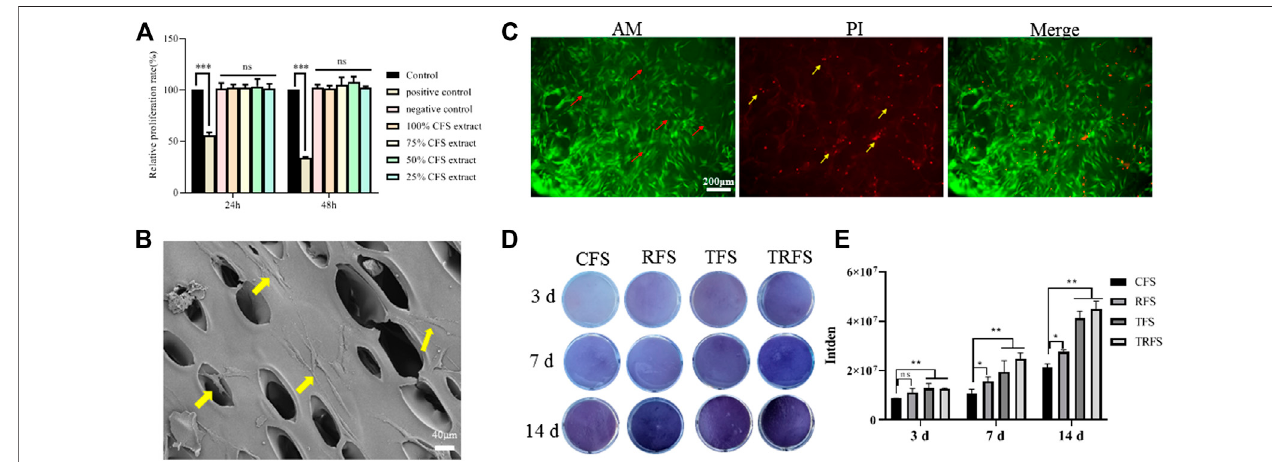
FIGURE 2 | Cell growth and osteogenic differentiation on TRFS (A) Detection of TRFS extract effect on the growth of hPDLSCs using MTT assay ( n (cid:1) 6, * p < 0.05, ** p < 0.01,*** p < 0.001,nsmeansnosigni fi cantdifference vs control) (B) ThegrowthofhPDLSCsonTRFSwasobservedusingSEM (C) Calcein-AM/PIdoublestaining wasusedtoobservethesurvivalofhPDLSCsculturedonTRFSfor7 days.Redarrowsindicatelivingcells,andyellowarrowsindicatedeadcells (D) ALPstaining(purple) wasusedtodetecttheALPactivityofhPDLSCsinCFS,RFS,TFS,andTRFSafter3,7,and14 daysofosteogenicinduction (E) Quantitativeanalysisofcolordepth ( n (cid:1) 3, * p < 0.05, ** p < 0.01, ns means no signi fi cant difference vs CFS).